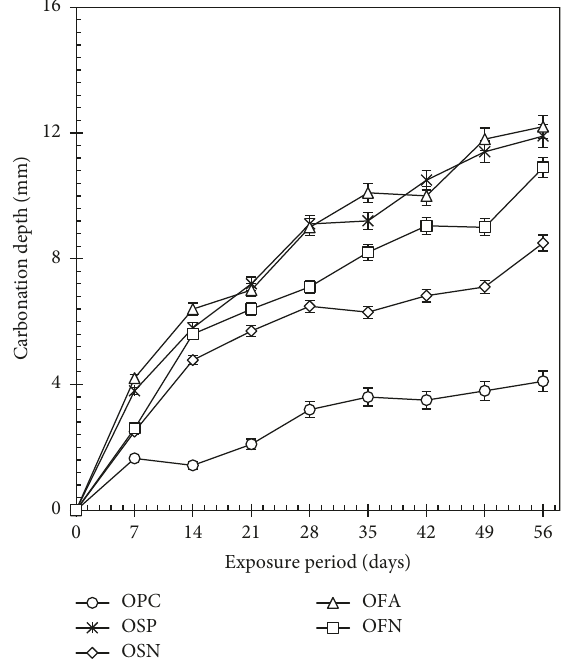
Figure 8: Carbonation depth for hardened concrete for